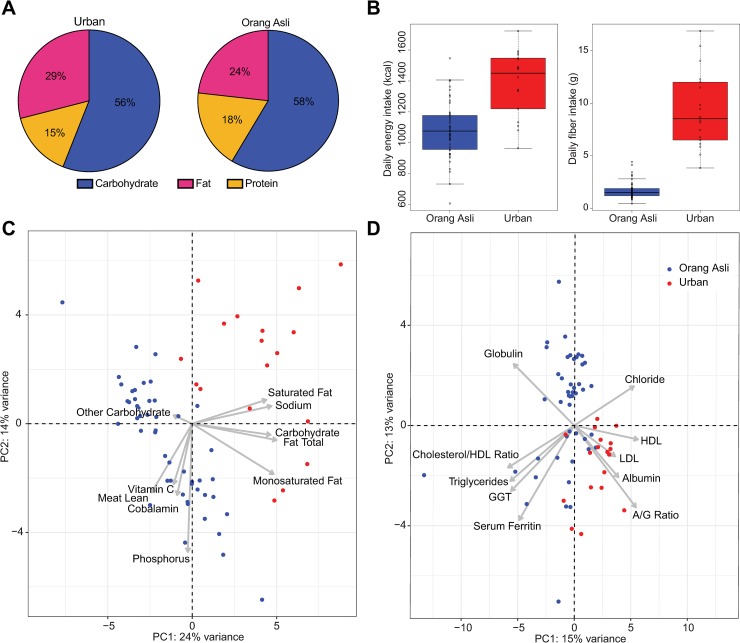
Dietary intake and nutritional status of study participants.(A) The proportion of dietary calories from carbohydrate, protein and fat among 49 Orang Asli (right) and 18 urban participants (left). (B) Daily energy intake in kilocalories was significantly higher (two-sample t-test, p<0.0001) in the urban study population (1386 ± 50) than in Orang Asli participants (1082 ± 26). Similarly, daily fiber intake (in grams) was significantly higher (two-sample t-test, p<0.0001) in the urban study population (9.35 ± 0.86) than in Orang Asli participants (1.74 ± 0.12). PCA based on (C) nutritional profiles from these 49 Orang Asli and 18 urban participants. (D) PCA based on blood variables from 46 Orang Asli and 18 urban participants. PCA is visualized as biplots, where data points represent PCA scores of individual samples while arrows represent loading values, which indicate the direction and magnitude of association between individual variables and PCs 1–2. Only nutritional and blood variables with the five most positive and most negative loading values on PC 1 are visualized.